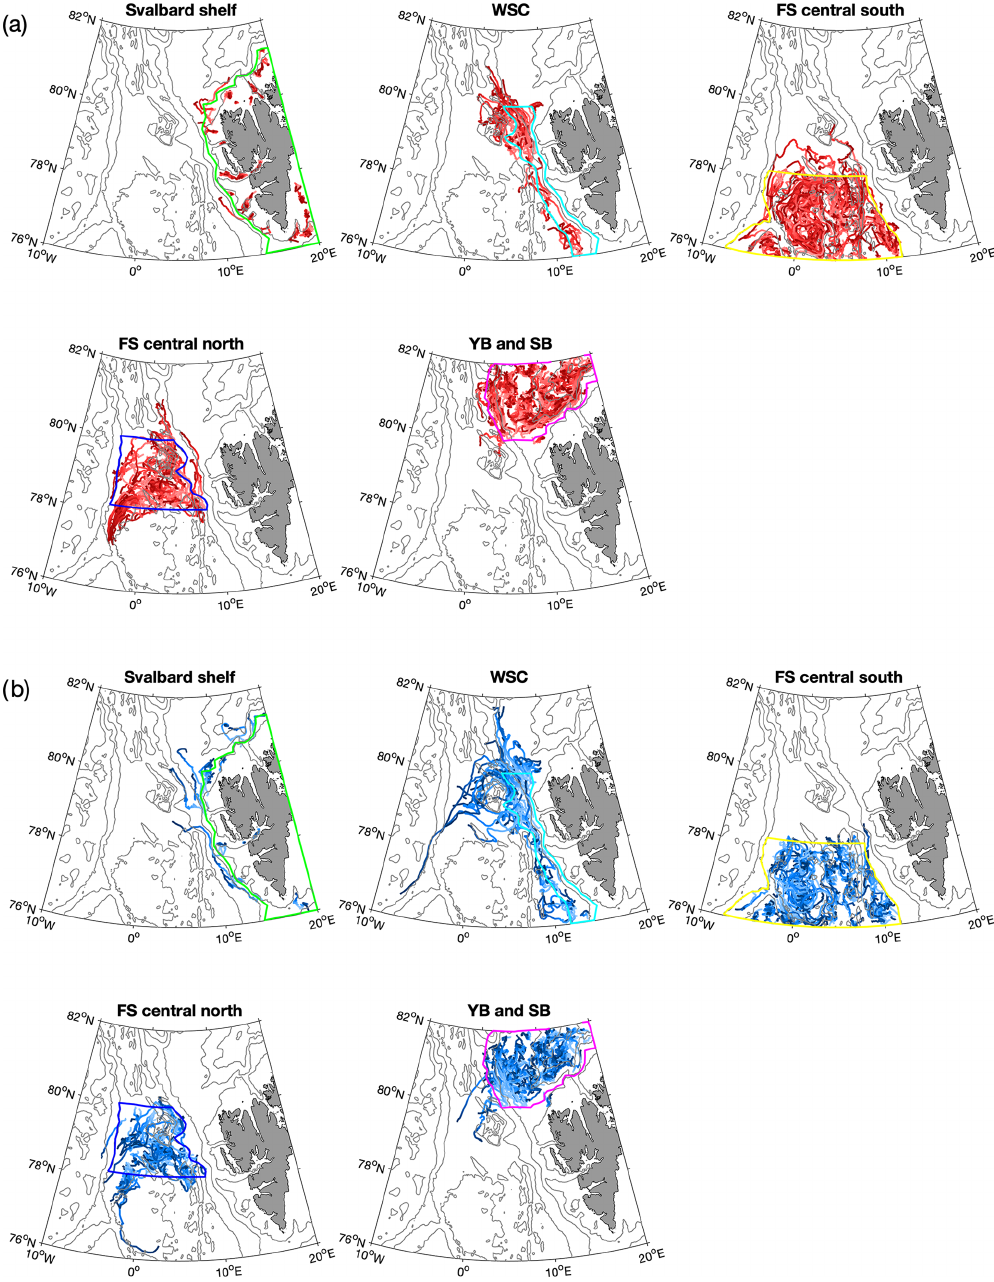
Figure 9. The same as Fig. 8, but for FESOM.